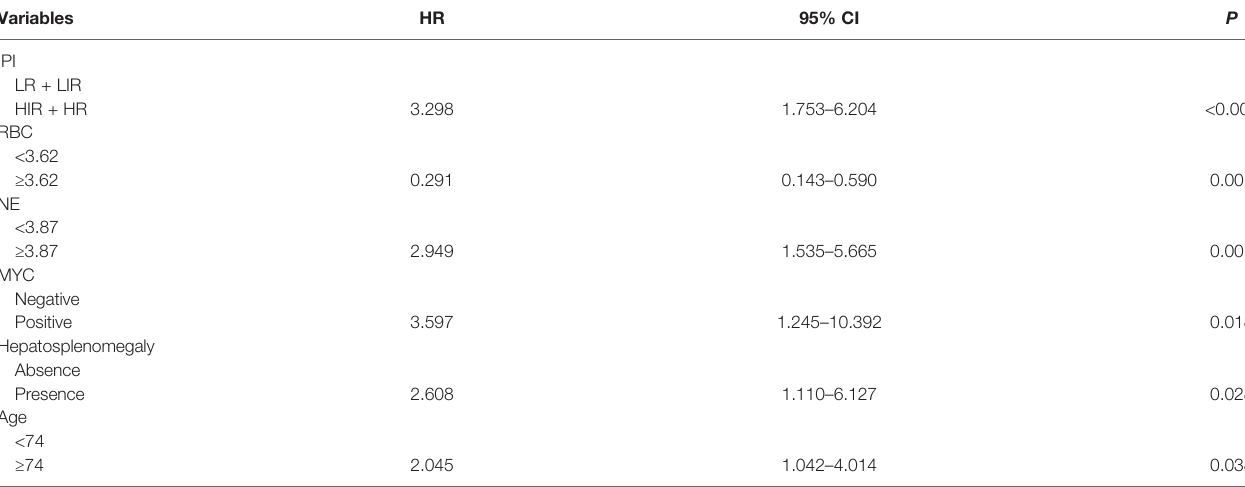
TABLE 2 | Multivariable analysis of OS in the derivation cohort.